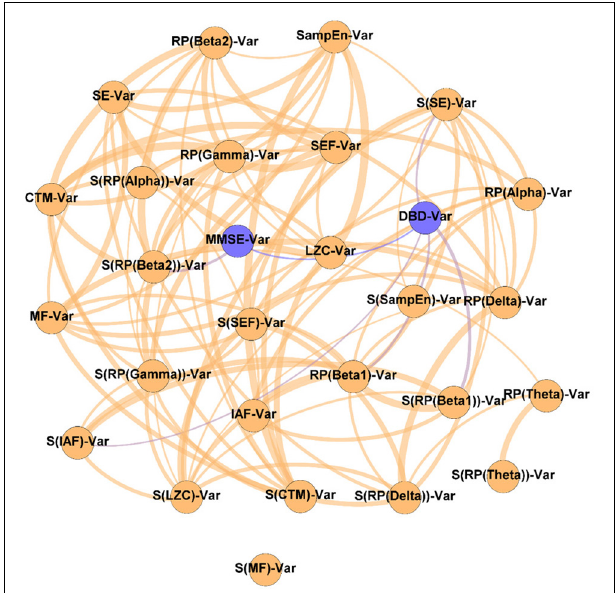
FIGURE 5 | Network of changes. As indicated by the “Var” suffix, this network displays the relationships between the variation of the parameters under study during the NPT (i.e., Parameter Post − Parameter Pre ). Wider edges correspond with stronger associations. Nodes corresponding to cognitive and behavioral parameters are shown in blue, while nodes of neurophysiological parameters are shown in